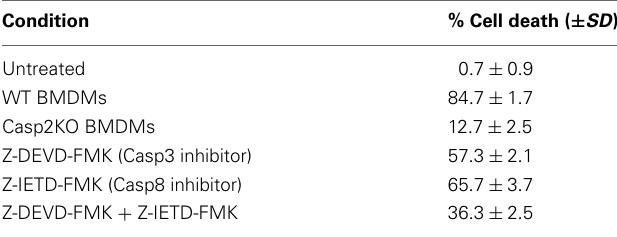
Table 1 | Cell death measurements in caspase-2 deficient and caspase-3 and -8 inhibited macrophages. Condition